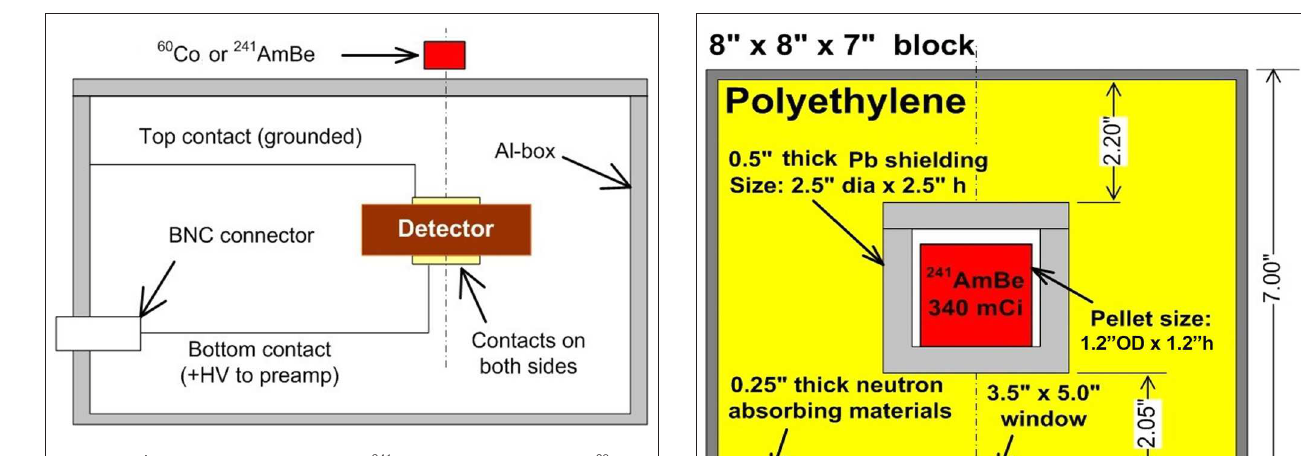
FIGURE 3 | Schematic of test setup with 241 AmBe neutron source and 60 Co gamma-ray source.